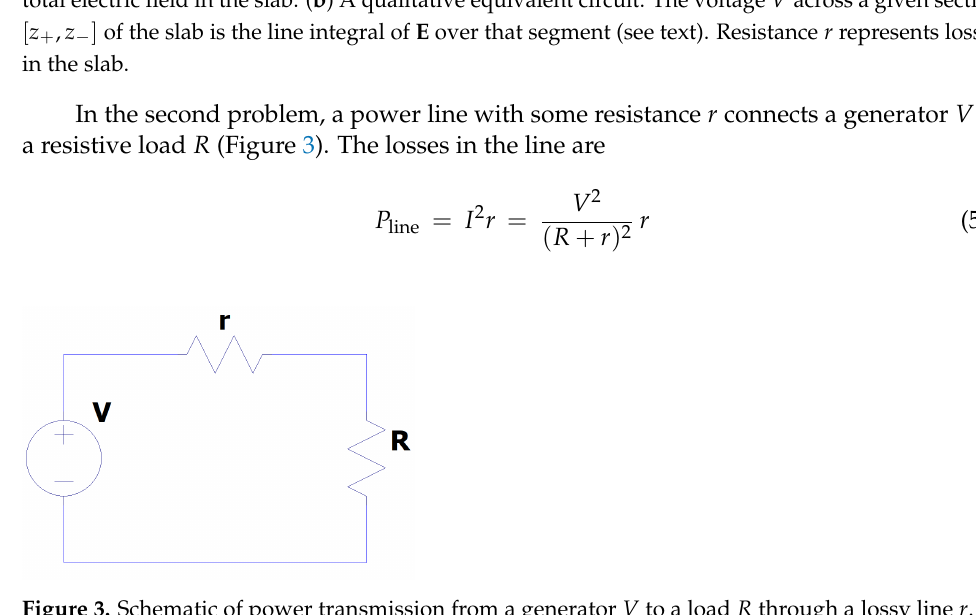
Figure 3. Schematic of power transmission from a generator V to a load R through a lossy line r